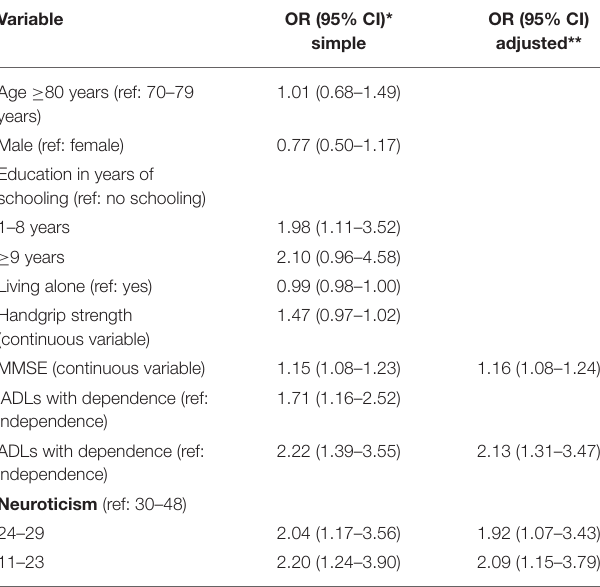
TABLE 4 | Results of simple and multiple logistic regression analyses for self-rated health as “good” or “very good” in the Portuguese sample. Variable OR (95% CI)*